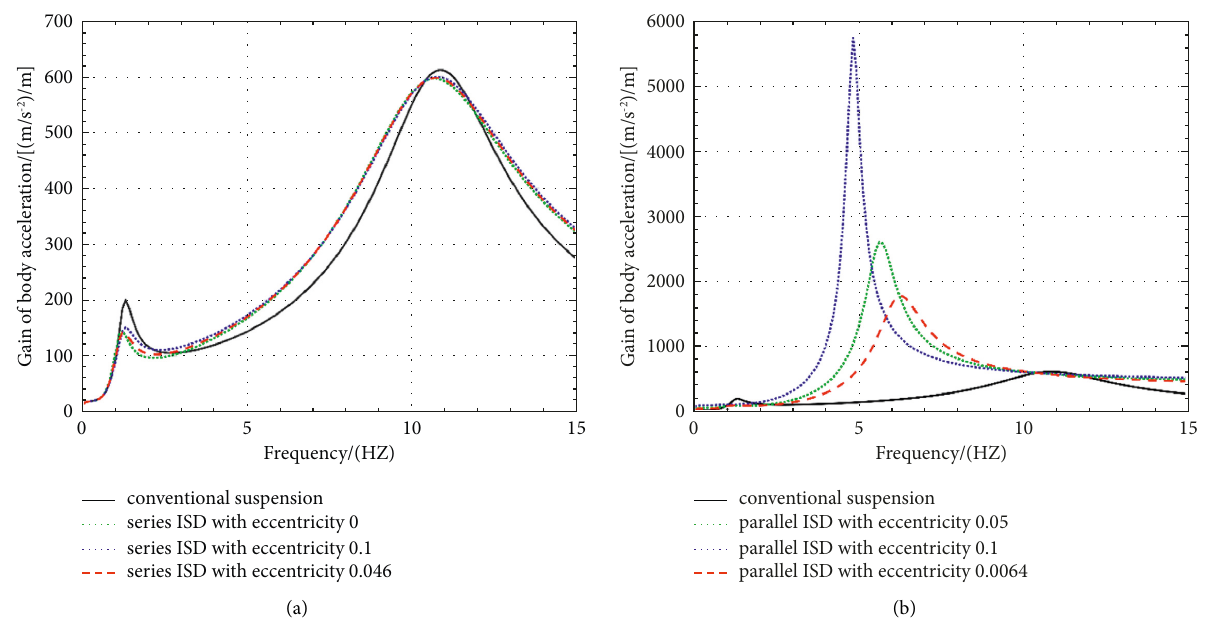
Figure 7: Responses of vehicle body acceleration in frequency domain.